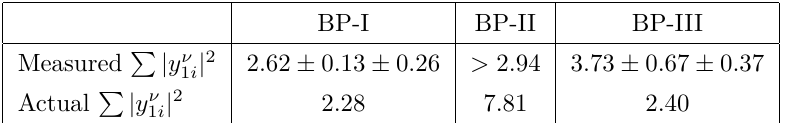
Table 5 . The sums of neutrino Yukawa couplings from displacements and the actual input values in units of 10 − 13 . The first uncertainty is statistical and the second one is a 10% theoretical uncertainty related to the ambiguity between the CP-even/odd Higgs states as discussed in the text. For BP-II the decay length was so short that we only quote a lower limit for the Yukawa